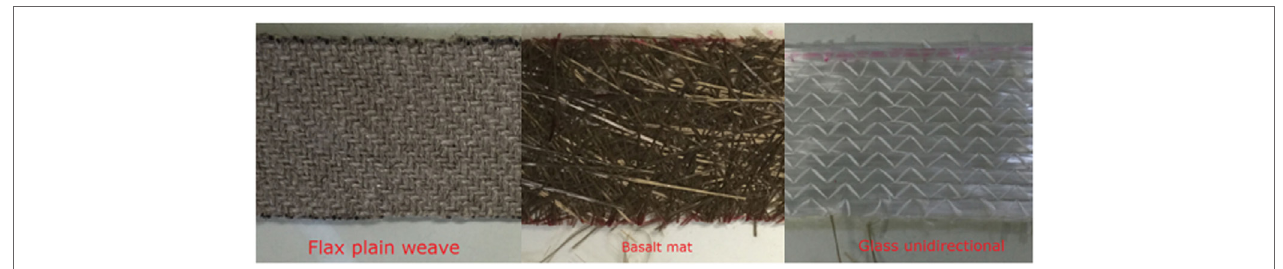
FigUre 2 | Photo of flax, basalt, and E-glass